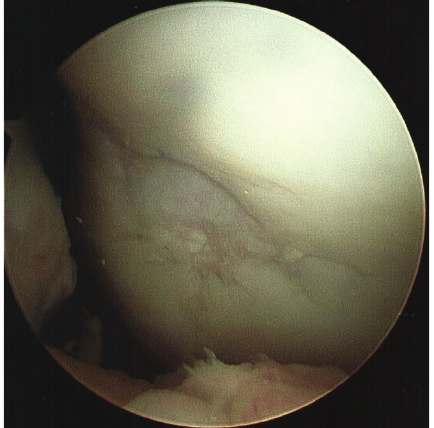
Figure 4: Repaired trochlear defect. Nine months following the trochlear defect repair, the repaired trochlear was visualized. Of note, there was a hyaline-like material and fraying of hyaline cartilage around the damaged area. No bare bone was observed. The fraying around the graft was determined to be clinically inconsequential and did not represent interference of stable fixation between the underlying graft and the bone. The density of the repair tissue was consistent with the surrounding, normal chondral